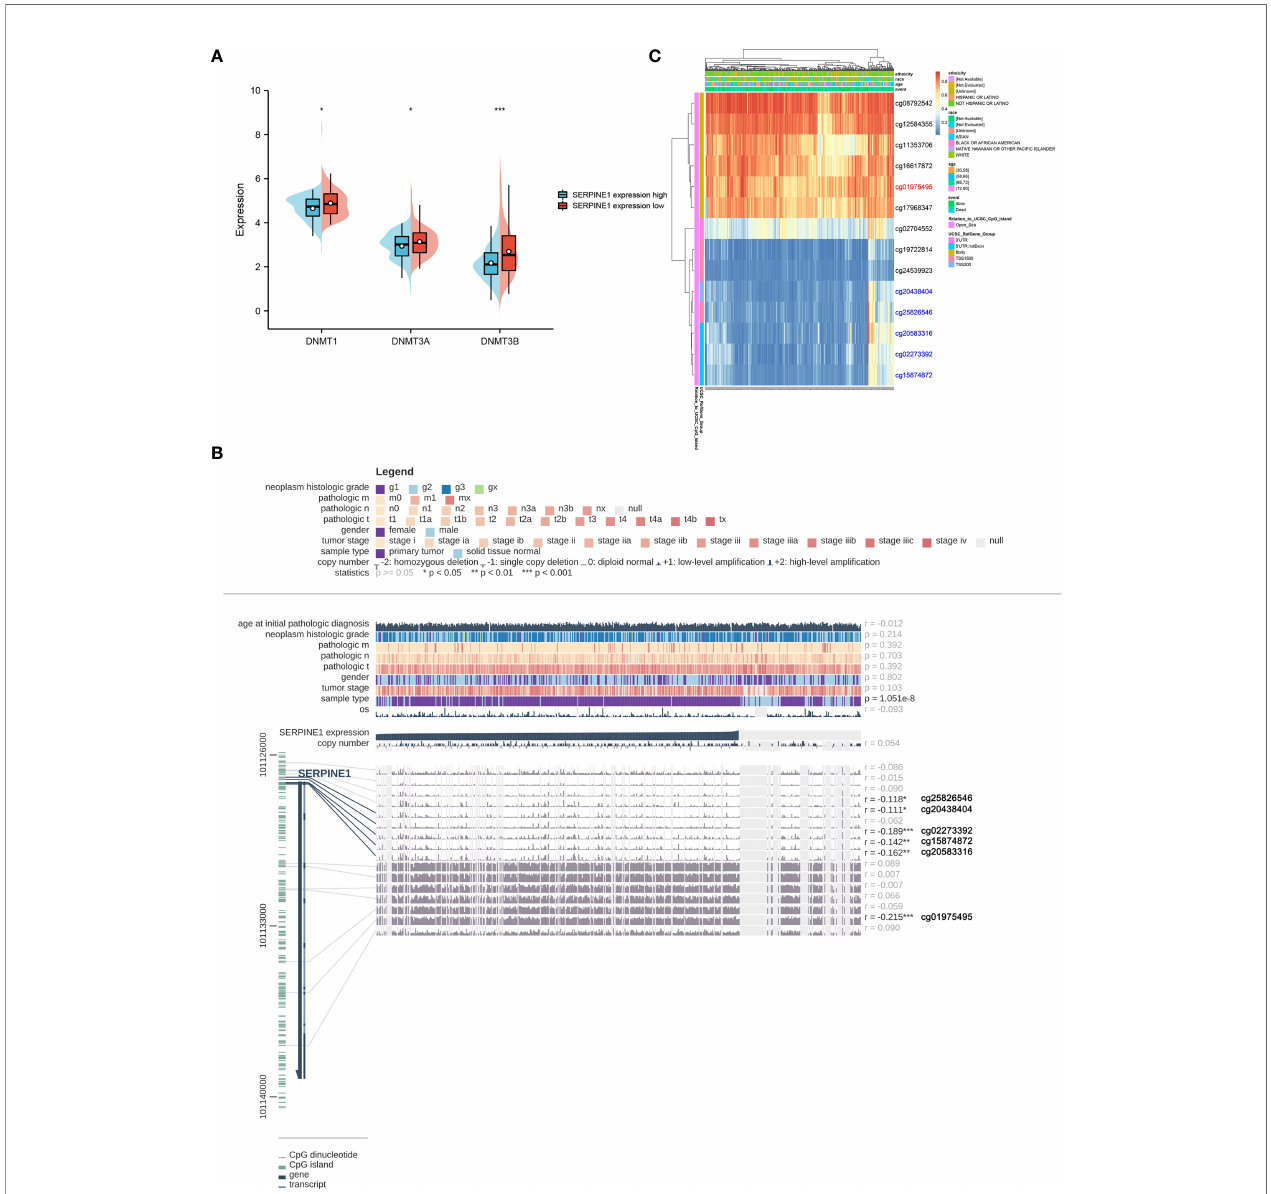
FIGURE 9 | Methylation analysis of SERPINE1. (A) Differential expression of three DNA methyltransferases (DNMT1, DNMT3A and DNMT3B). (B) The methylation site of SERPINE1 DNA sequence association with gene expression was visualized using MEXPRESS. The blue line illustrates the expression of SERPINE1 in the center of the plot. Pearson ’ s correlation coef fi cients and p values for methylation sites and query gene expression are shown on the right side. (C) Differently methylated regions associated with SERPINE1 were presented by heatmap using